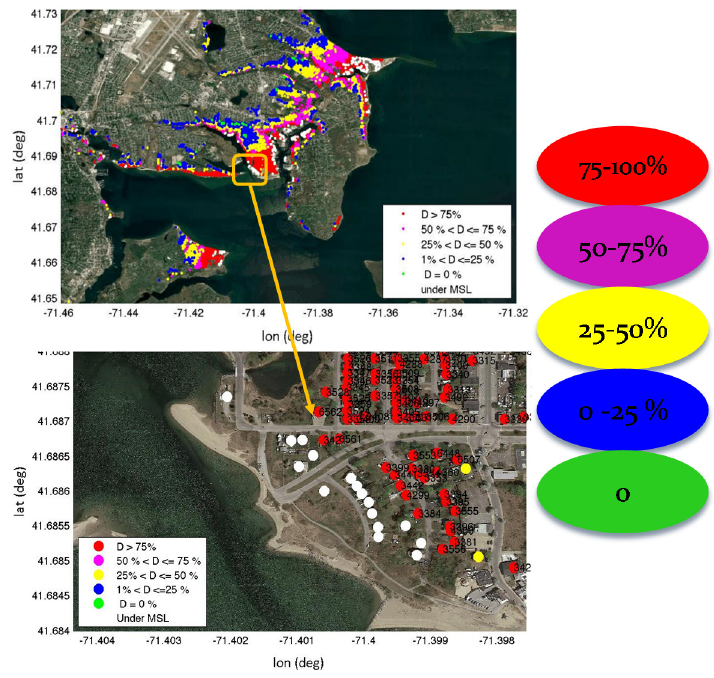
Figure A7. Percent damage by structure for Warwick, RI for 100 year storm plus 2.1 m (7 feet) SLR. Structures that are below MSL are noted by white dots and those removed by erosion are given by black dots. Progressively higher resolution maps of results (upper and lower panels). Individual structure IDs are noted at the highest resolution (lower panel). The yellow circle in the upper panel shows the location of the higher resolution area in the lower panel.